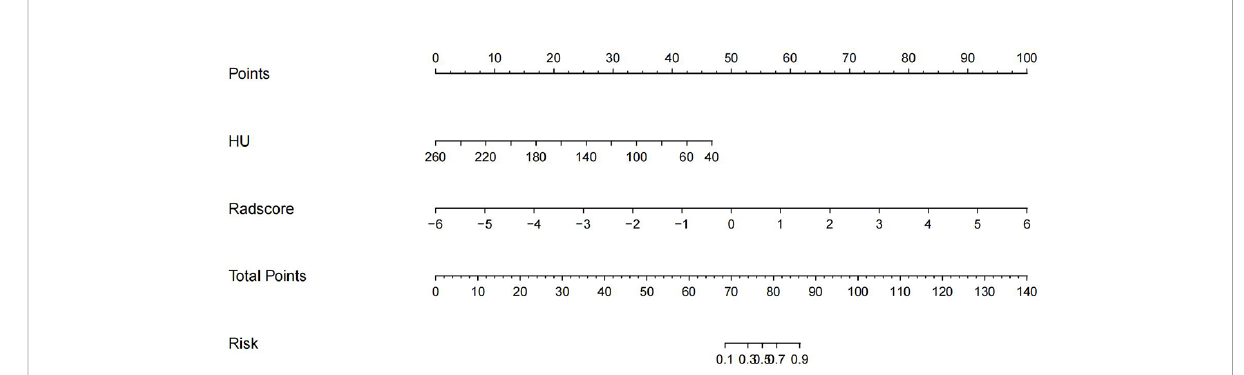
FIGURE 7 A nomogram of imaging-clinical joint model, including CT values of the vertebral body and